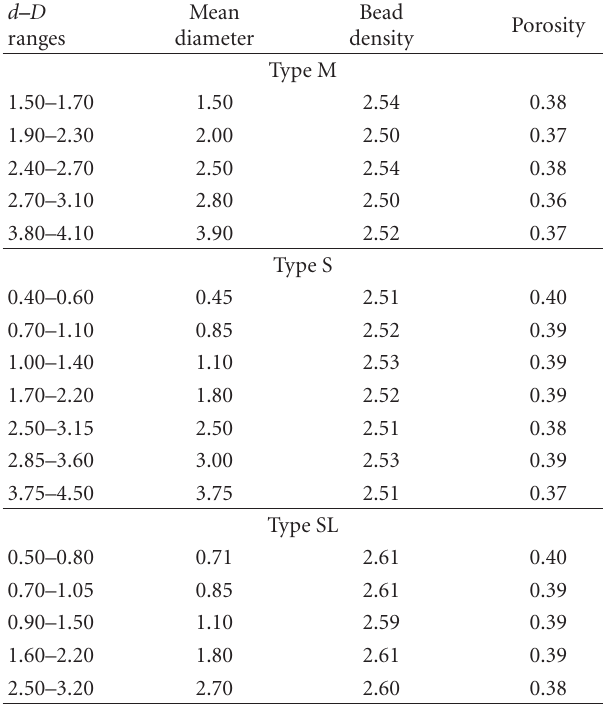
Table 1: Diameter ranges ( d–D ), mean diameter, glass bead density and porosity of the glass bead assemblages for the M, S, and SL glass